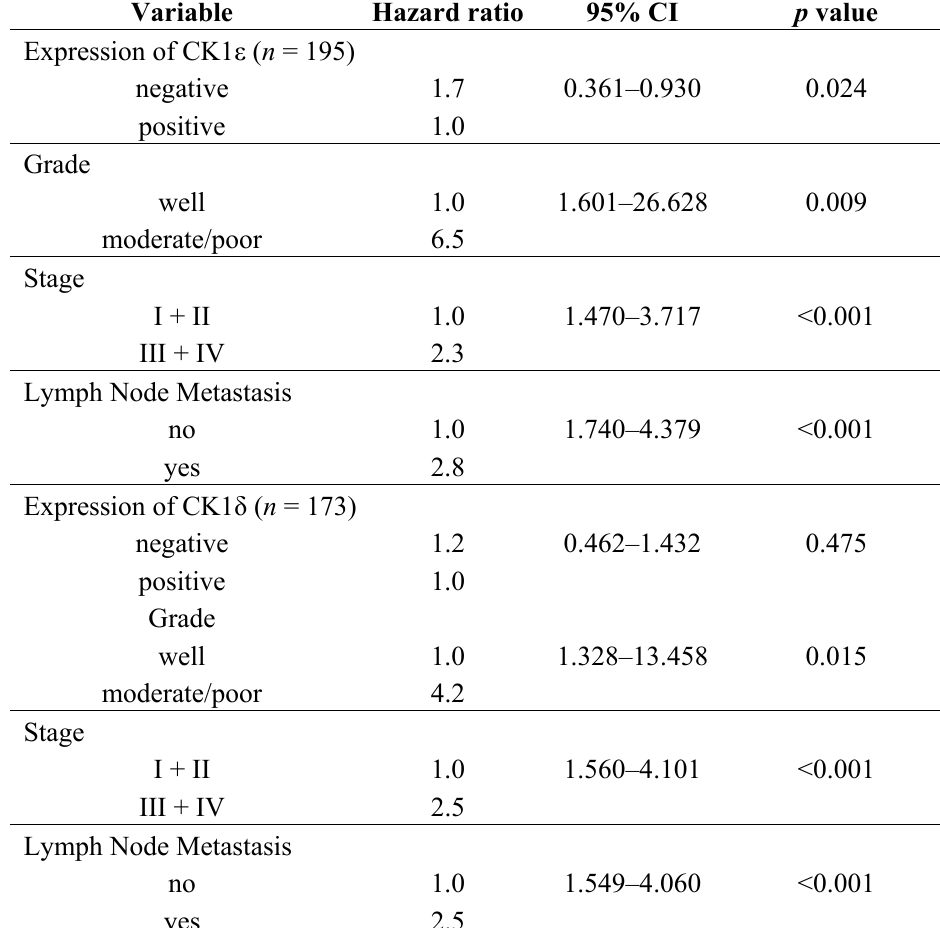
Table 3. Univariate analysis (Cox regression) of several clinicopathologic indicators of oral